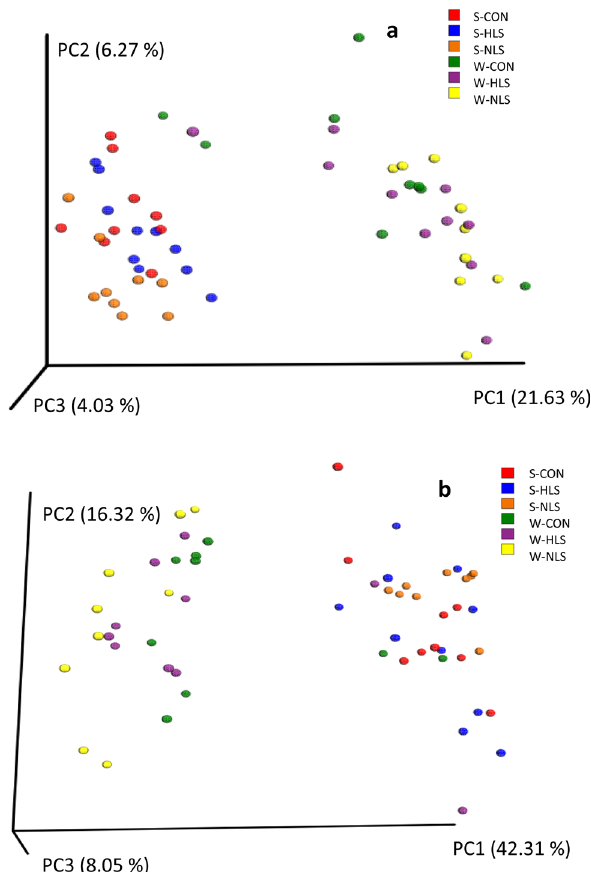
Figure 4. Beta diversity patterns of fecal microbial diversity in at the beginning (d 4, suckling) and end of the experiment (d 21, weaning) as assessed by principal coordinate analysis (PCoA) of unweighted and Weighted Unifrac. CON, Control without probiotic; HLS, L. salivarius 144 isolated from fast-growing pig feces; NLS, L. salivarius 160 isolated from normal weight pig